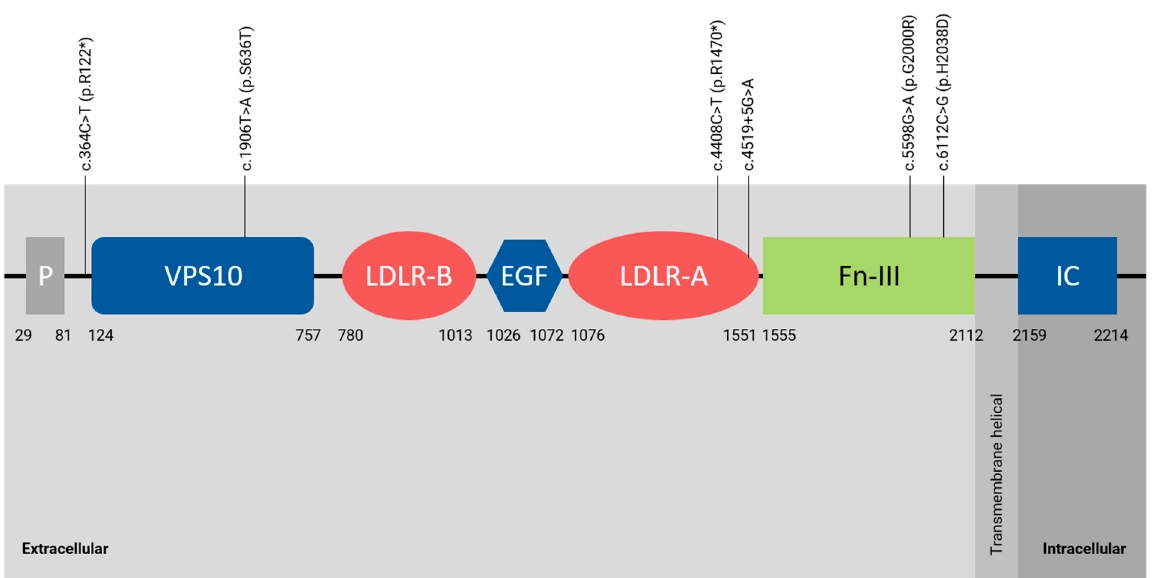
Figure 1. Graphical description of SORL1 variants (NM_003105.6) identified in this report. Abbreviations. EGF: epidermal growth factor like domain; Fn-III: fibronectin-type III domain; IC: intracellular domain; LDLR-A and LDLR-B: low density lipoprotein receptor A and B domains; P: pro-peptide; VPS10: vacuolar protein sorting 10 domain. Table 2. Molecular description of SORL1 variants (NM_003105.6) identified in this